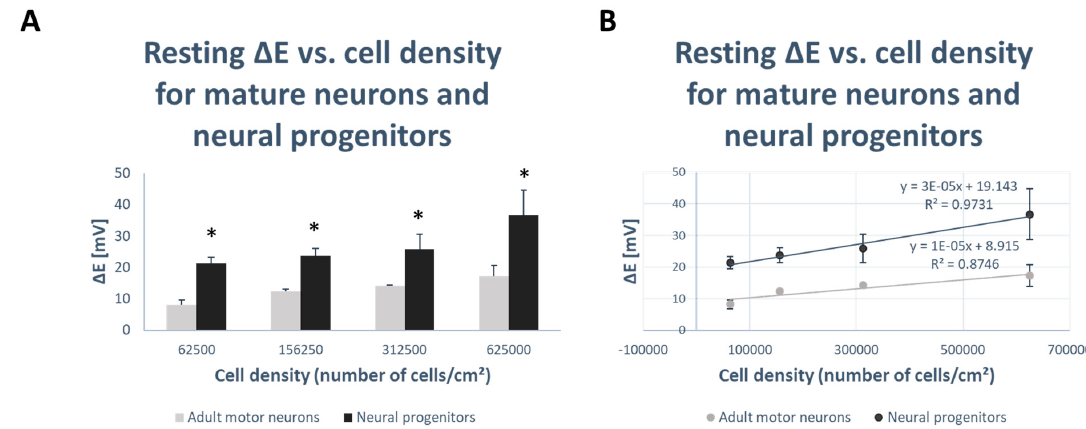
Figure 3. Microplate readings of mature and immature resting neural cultures. ( A ) The resting membrane potential of mature neurons versus immature neural progenitors at varying cell densities shows that the more hyperpolarized membranes of mature neurons are detectable using our method. ( B ) The relationship between the resting membrane potential readings and cell densities is linear with a high correlation coefficient of 0.97. Data is presented as the average and standard deviation of three biological replicates. Statistics were performed by one-way student t -test assuming two sample equal variance. * signifies statistical significance between the Neural progenitor readings versus the Adult motor neuron readings.